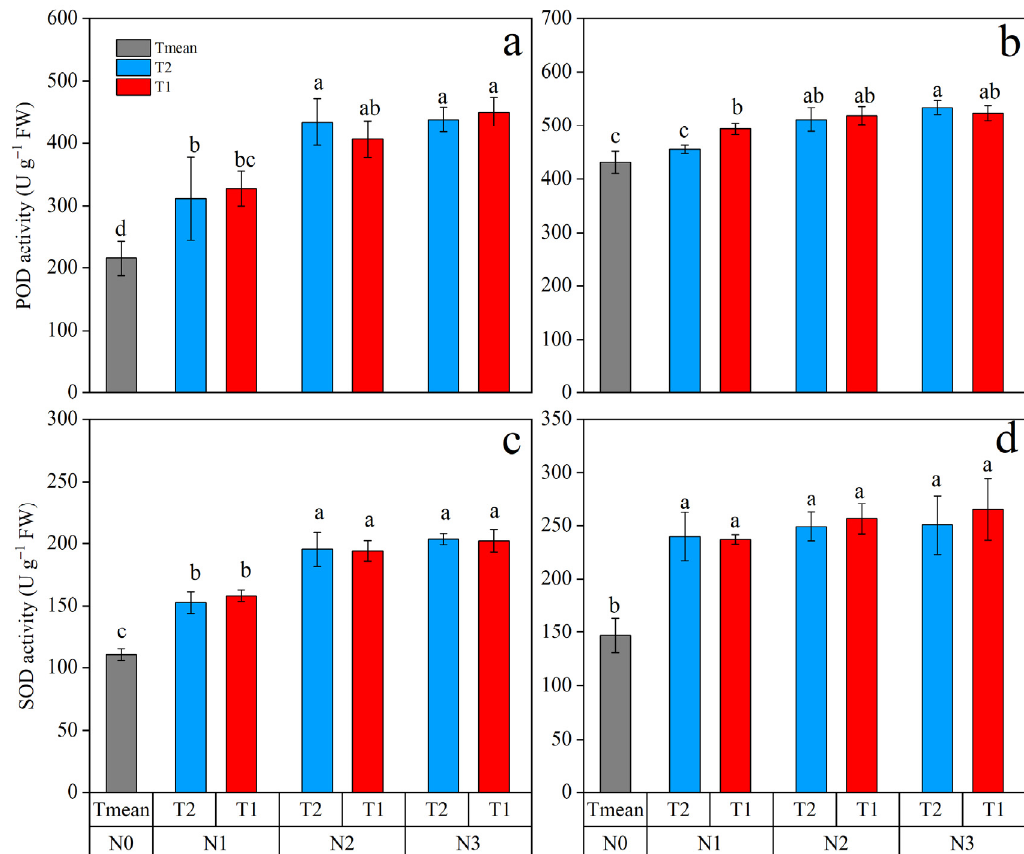
Figure 5. Activity of peroxidase (POD) and superoxide dismutase (SOD) enzymes in leaves of maize affected by N supply in 2019 ( a , c ) and 2020 ( b , d ). Different letters indicate significant differences at p < 0.05.